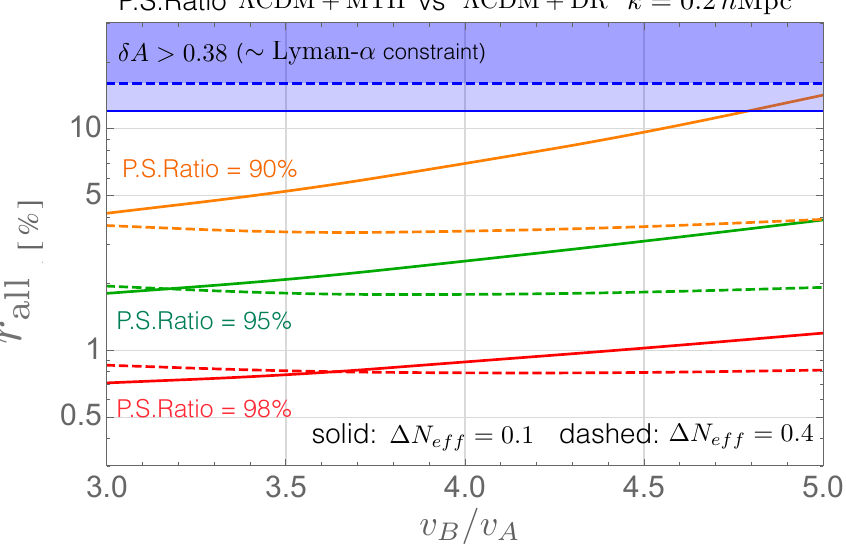
Figure 8 . Estimation of projected constraints on the twin baryon mass fraction r LSS measurements, as a function of v B =v A . Next generation lensing measurements are expected to bound the power spectrum suppression at the few percent level [98], so we show the constraints arising from the 90, 95 and 98% lower limits on the ratio of power spectra de(cid:12)ned in eq. (3.13) as the orange, green and red curves. The ratio of the densities of twin hydrogen and helium are obtained from (cid:12)gure 1. The region above the solid (dashed) blue line for (cid:1) N e(cid:11) = 0 : 1 (0 : 4) represents an approximation to the Lyman- (cid:11) constraint that excludes scenarios with (cid:14)A , the deviation of the integrated power spectrum de(cid:12)ned in eq. (3.17), larger than